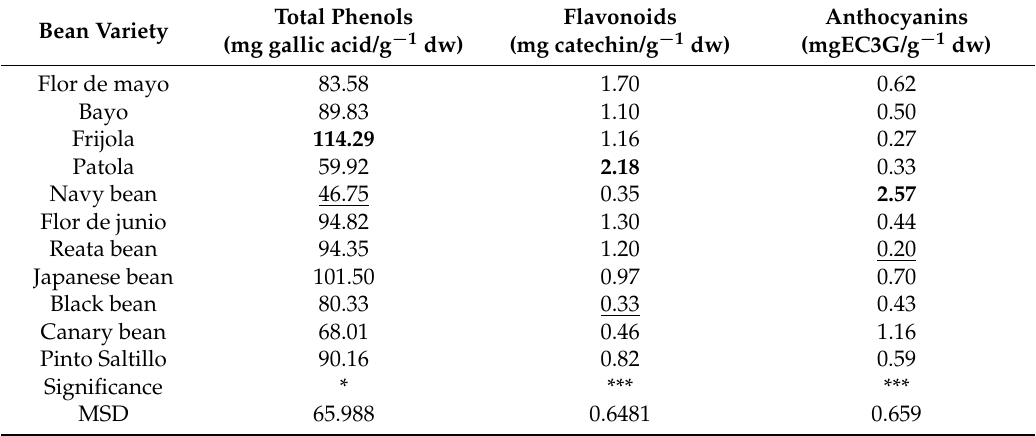
Table 7. Concentration of bioactive compounds in bean varieties grown and consumed in the state of Zacatecas,